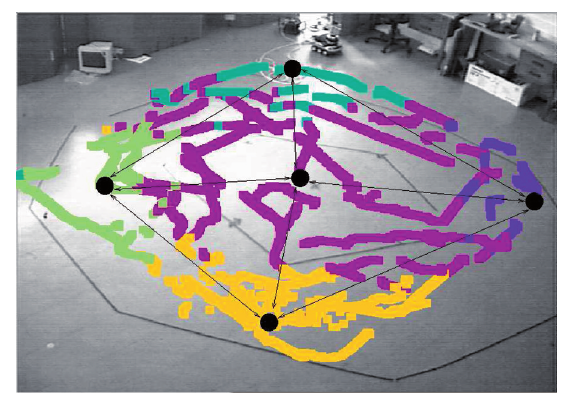
Figure 12. Five PCs have been learned in the environment. Each color cor- responds to a place field. Information of the cognitive map are superimposed in black. Black circles are transitions cells from one place to itself. For more clarity, transitions have been represented with a double arrow. Each arrow